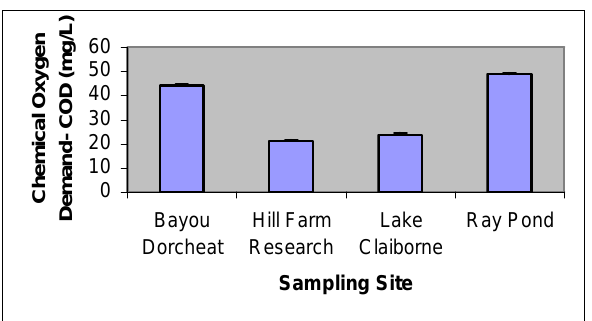
Figure 1: Mean values of chemical oxygen demand COD (mg/L) at each sample site (n=15).